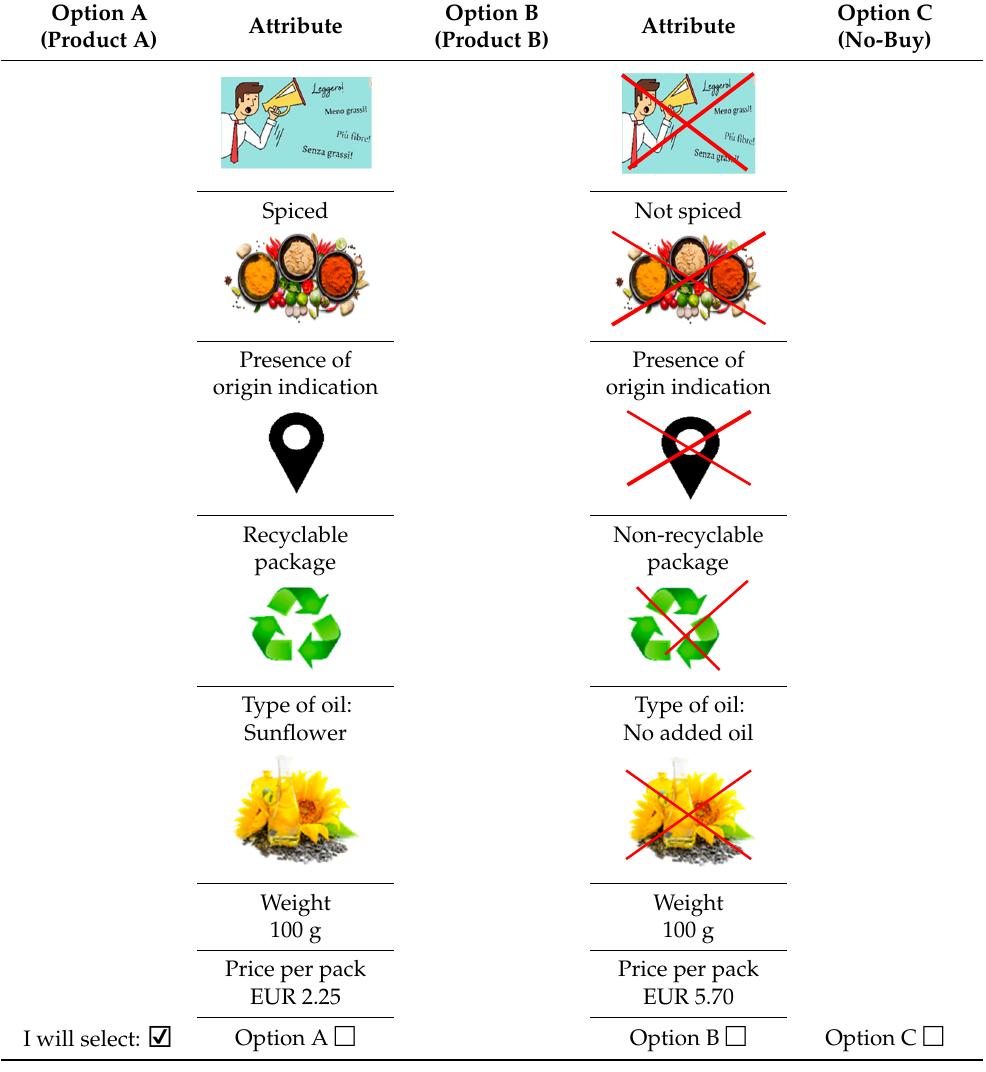
Table 3. Attributes and levels used in our discrete choice experiment.